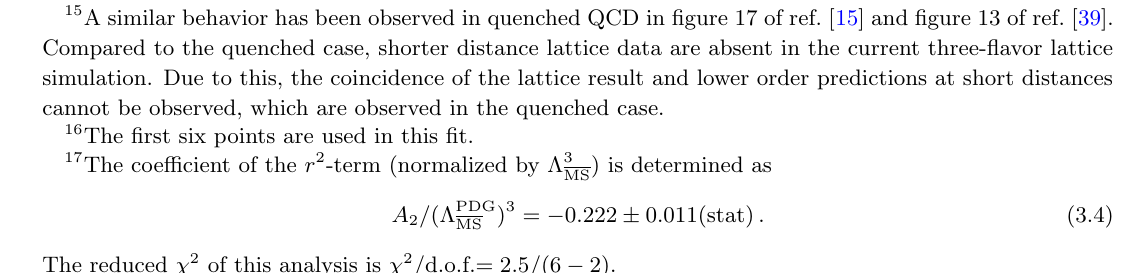
(black dots) with V RF at LL (red), NLL (green), S latt = 336 MeV MS